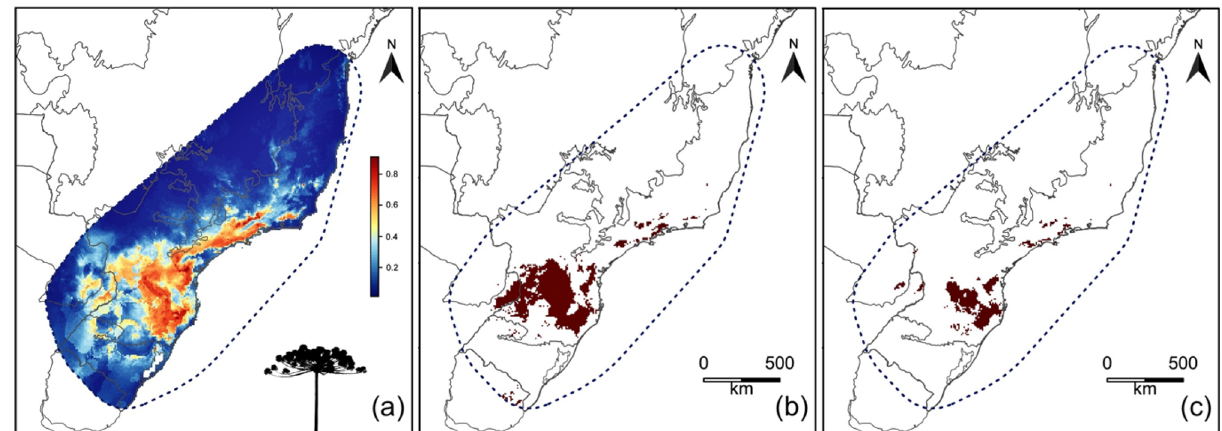
Figure 2. Decline of BAH by climate change for A. angustifolia , a species traditionally combined with other agricultural crops from Atlantic Forest. a) Current habitat suitability. Blue to red indicates the increase of suitability b-c) Future suitable habitats based on SSP2-4.5 and SSP5-8.5 scenarios for 2061–2080. Wine red colour indicates the remaining BAH. Estimated BAH is surrounded by dotted lines in royal blue colour. Maps created with custom R script. Version R 4.1.1 (https:// www.R- proje ct. org/). Base map source (Terrestrial biomes shapefile) obtained from the Brazilian Ministry of the Environment (https:// www. gov. br/ mma/).